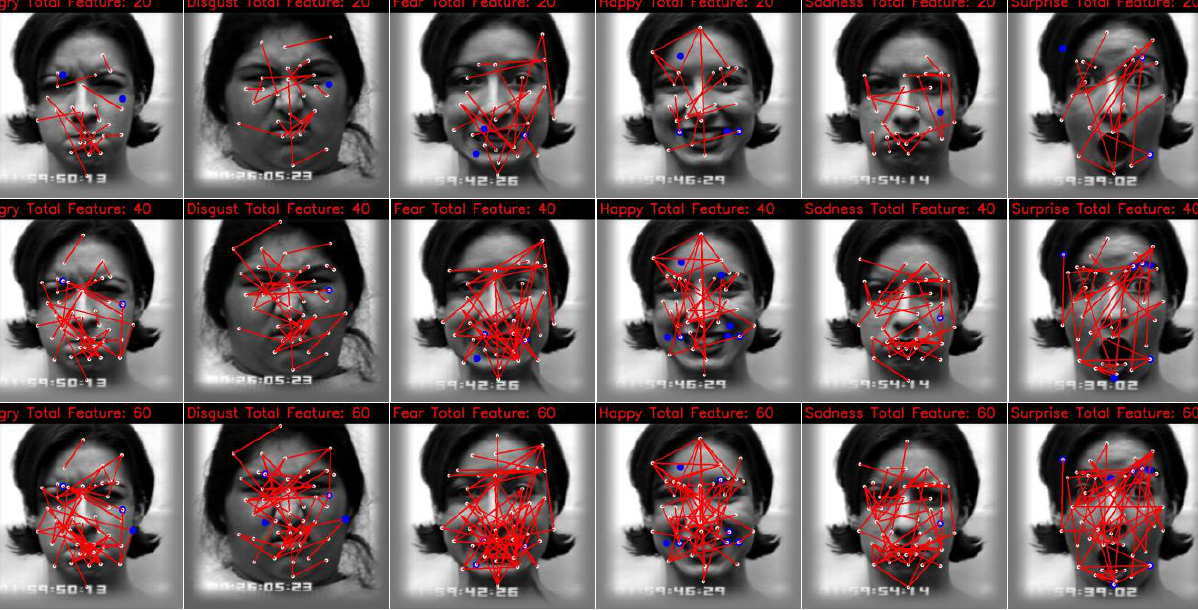
Figure 7. Grouping of landmarks into different regions according to the facial geometry.